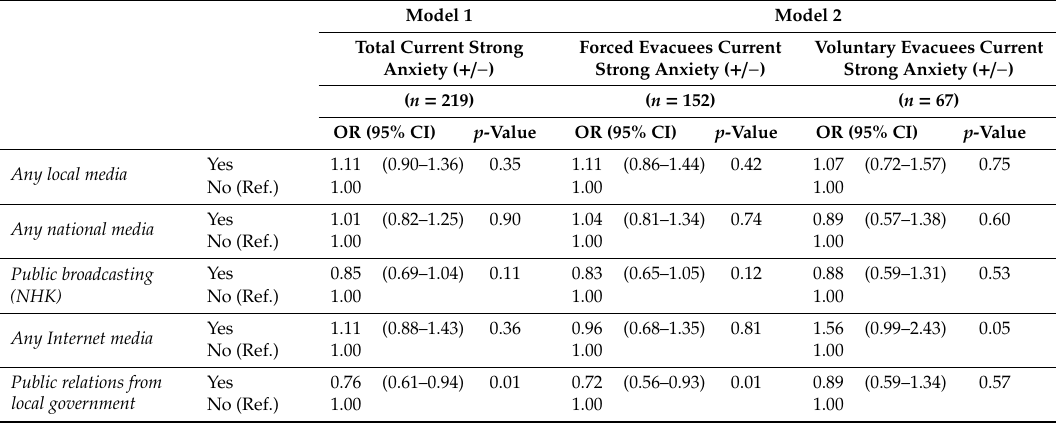
Table 5. Multivariate logistic regression analysis with utilized media and current strong anxiety (forced / voluntary